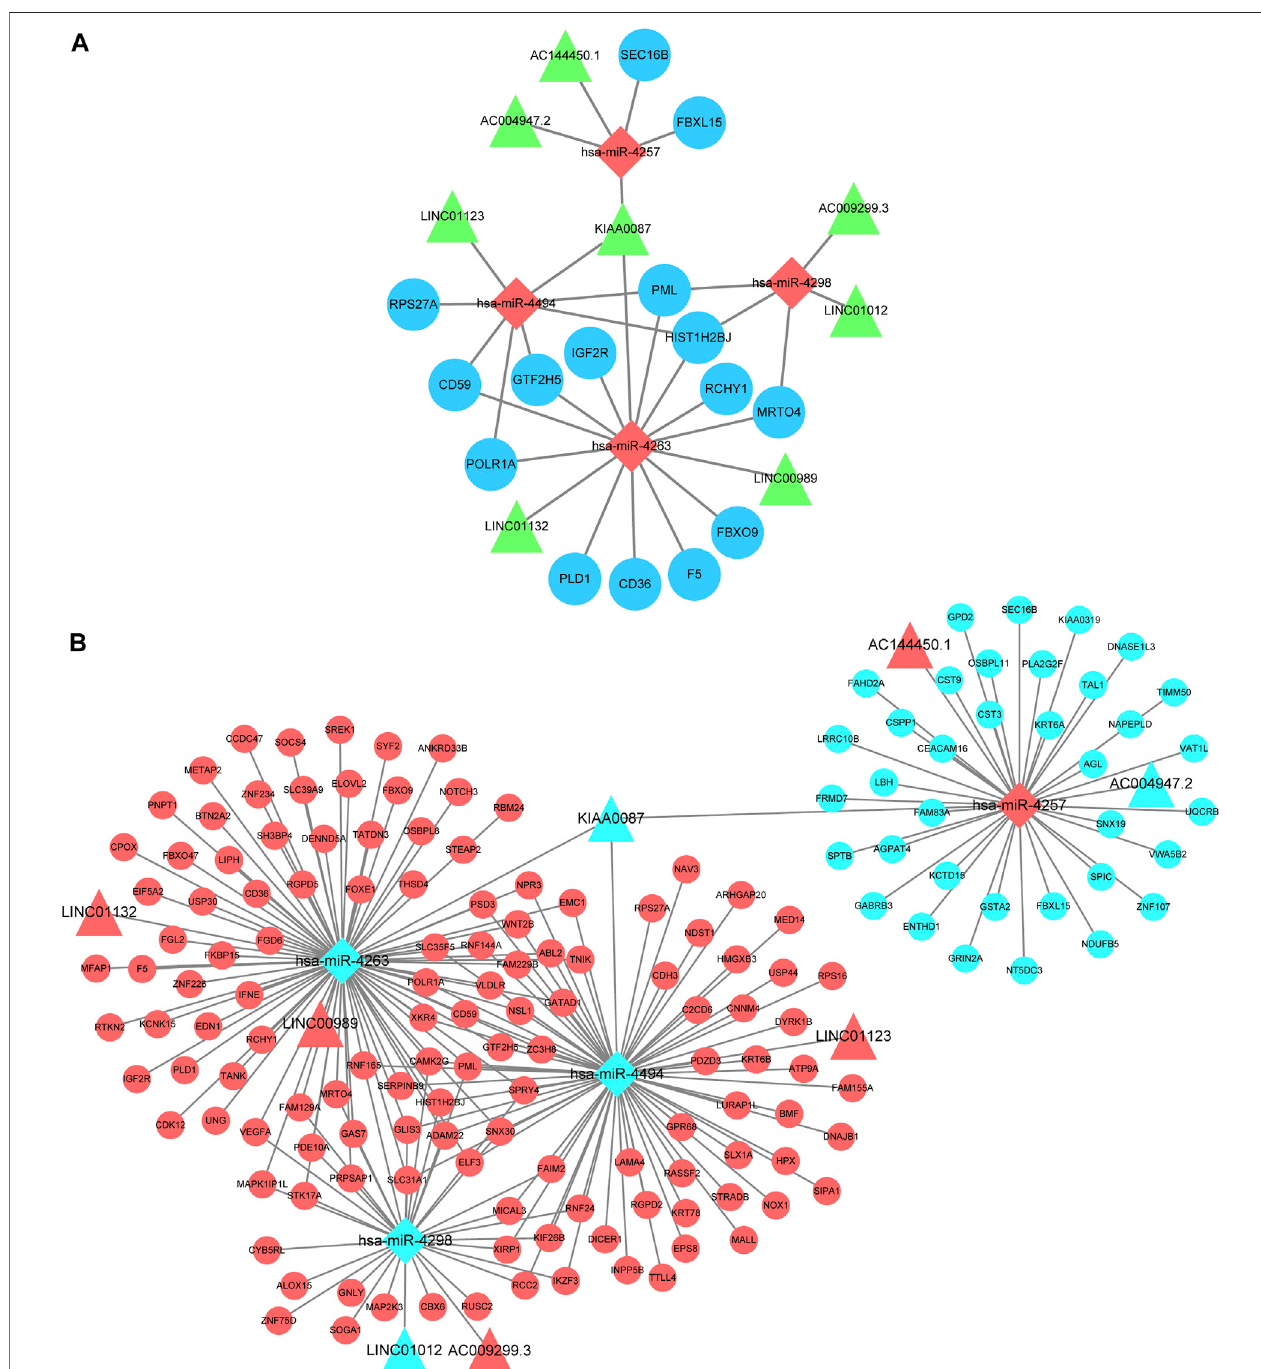
FIGURE8| CeRNA regulatory networkconstruction. (A) Hub ceRNA networkwhich contains 15top hub genesassociatedwith KC. Note: Circles represents hub genes, rhombus represents intersected miRNAs, and triangles represent intersected lncRNAs. (B) Cytoscape software visualizes the overall lncRNA – miRNA – mRNA regulatory network. Note: Circles represent intersected mRNAs, rhombus represents intersected miRNAs, and triangles represent intersected lncRNAs. Red means upregulated and light blue means downregulated.